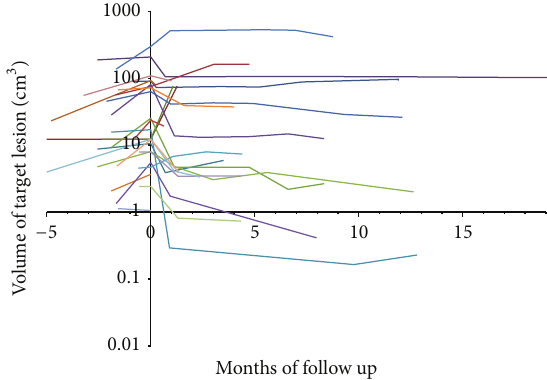
Figure 6: Target lesion volume changes in patients with metastases (each curve denotes an individual lesion). Most of the lesions show decrease in volume soon after treatment, followed by some additional decrease in volume, unless a recurrence